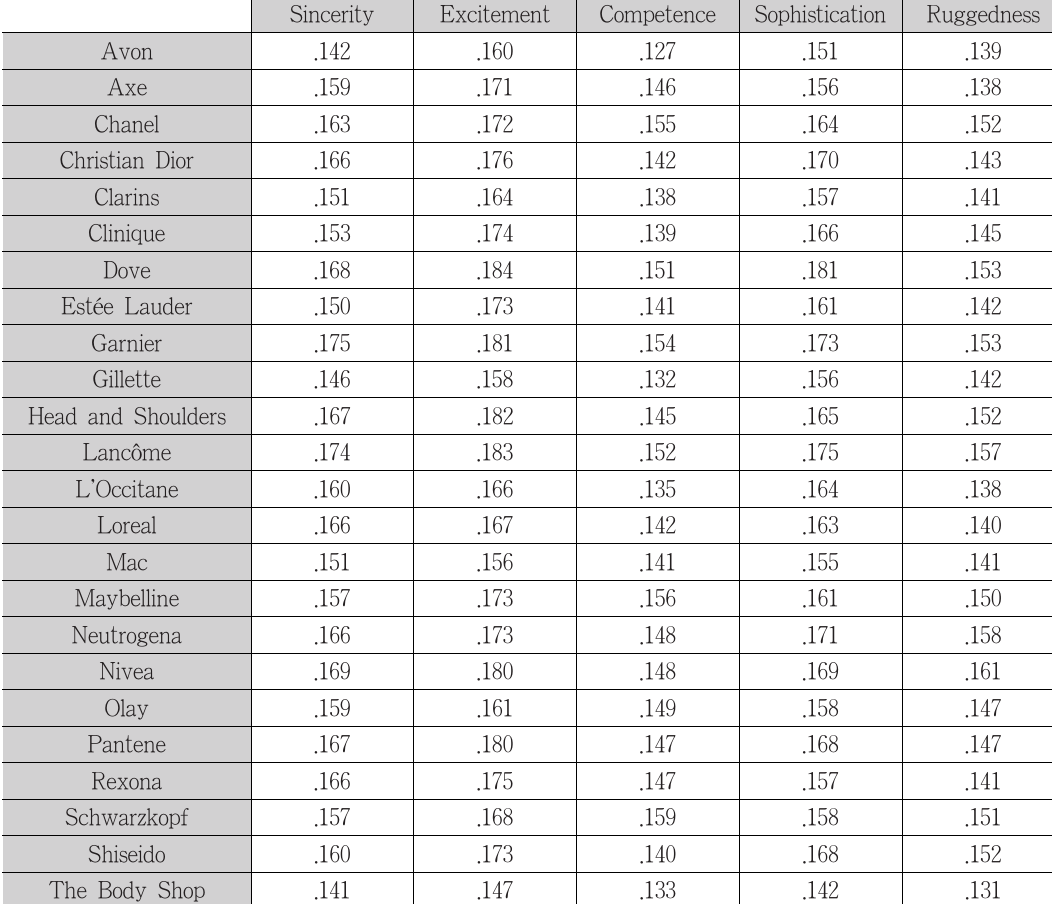
<Table 1> Mean similarity